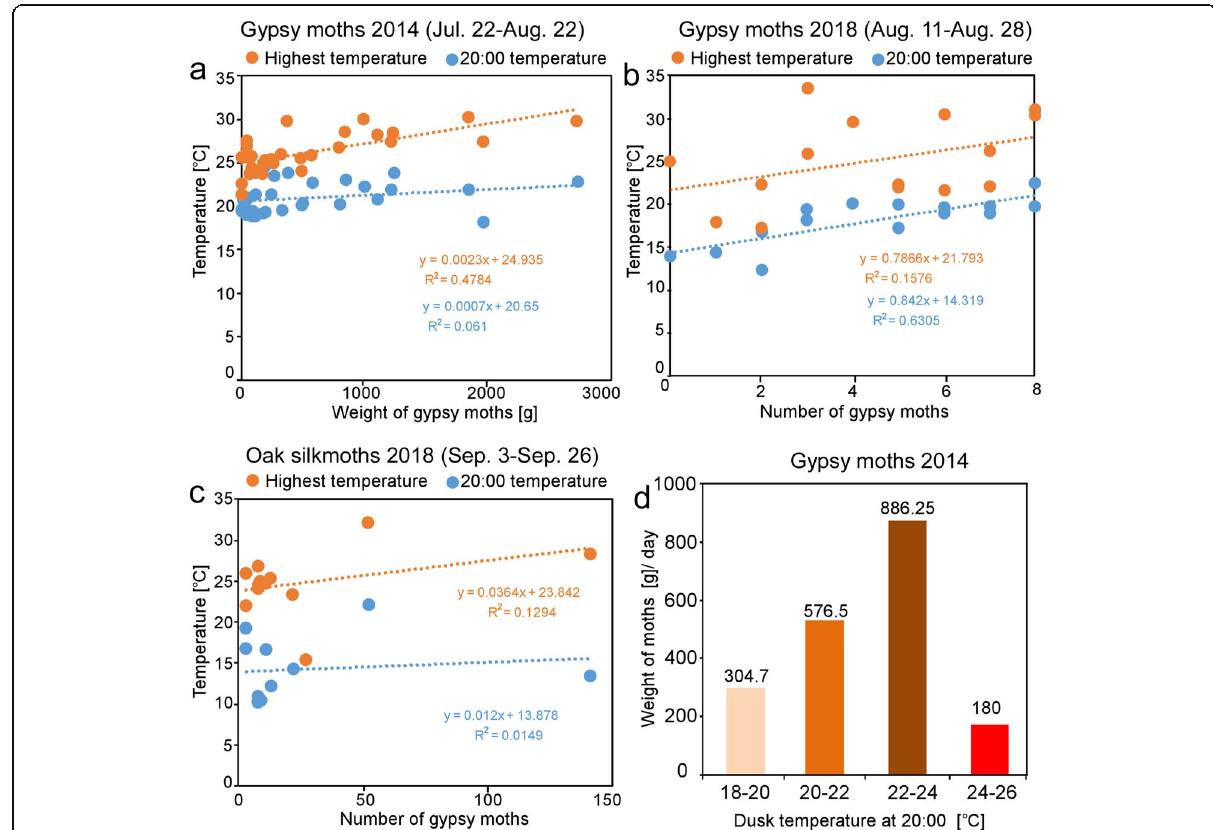
Fig. 8 Correlation analyses between daily moth catch and ambient temperatures on each catch day. At the Mt. Usu rest area in 2014 ( a ), the gypsy moth catch was correlated more strongly with the highest temperature than with the dusk temperature, but the opposite correlations were found in Yubari in 2018 ( b ). There were no correlations between oak moth catch and the highest temperature and dusk temperature ( c ). The highest number of gypsy moths was trapped when ambient temperatures ranged from 22 to 24 °C, but the number decreased at temperatures above 24 °C ( d